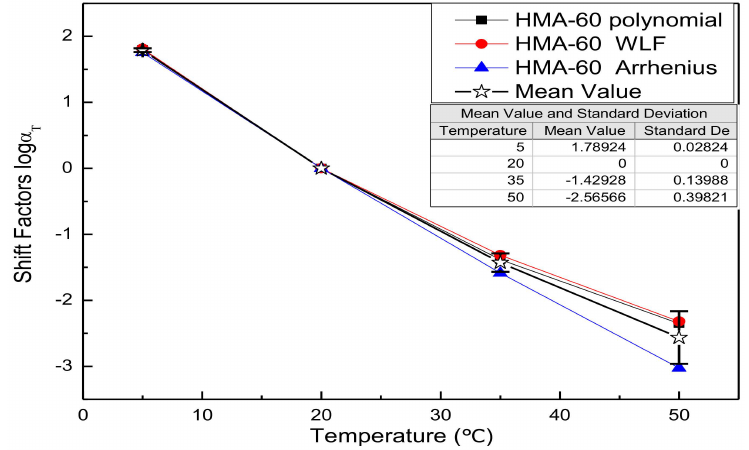
Figure 2. Shift factors of